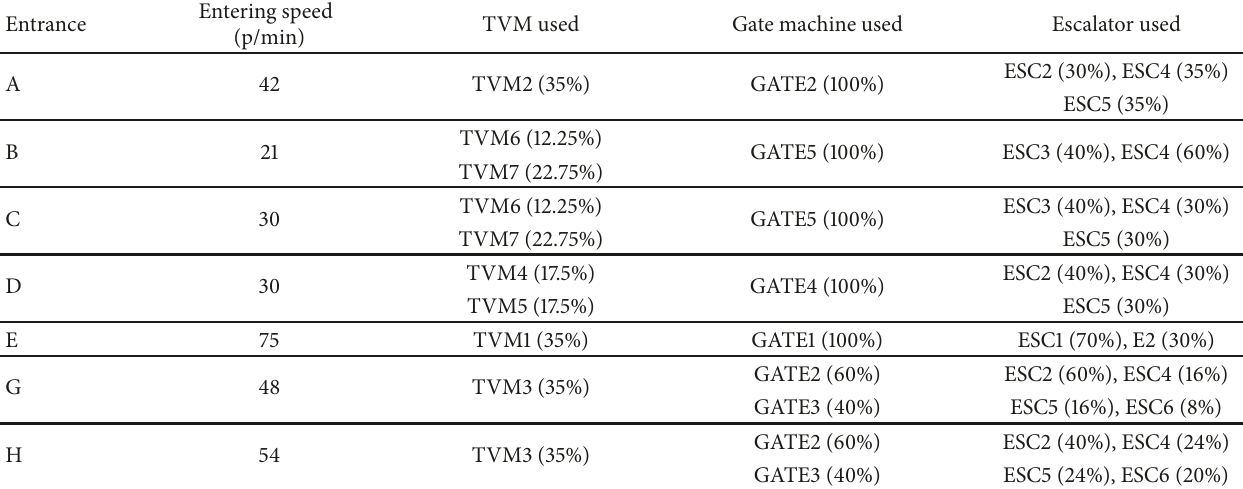
Table 4: Utilities of TVM, gate machines, and escalators.